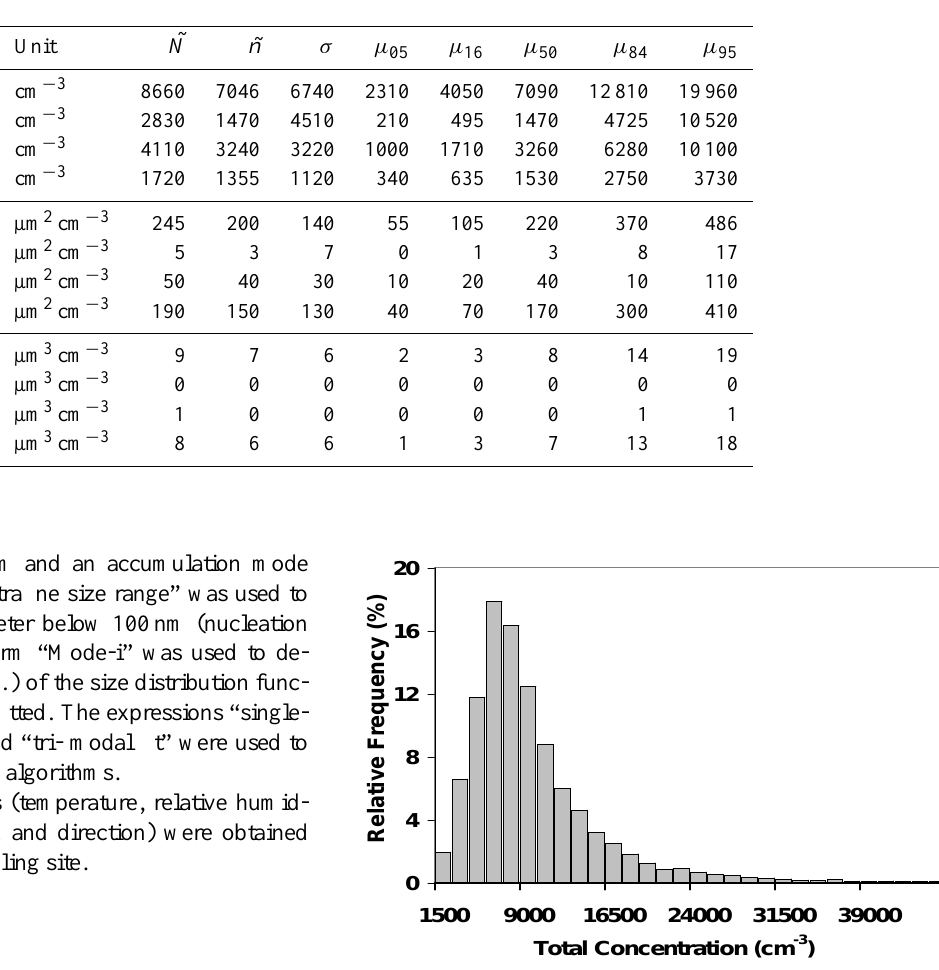
Table 1. Statistics for total and modal concentrations of several moments of the size distribution for 1-h year data series. ˜N is the arithmetic mean concentration, ˜n is the geometric mean concentration, σ is the standard deviation and µ x values are the x th percentiles.